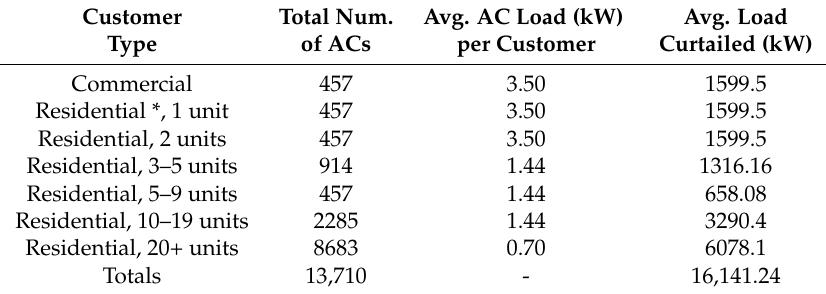
Table 2. Demand response (DR) load curtailment customer and load distribution for a 16 MW contingency in the whole